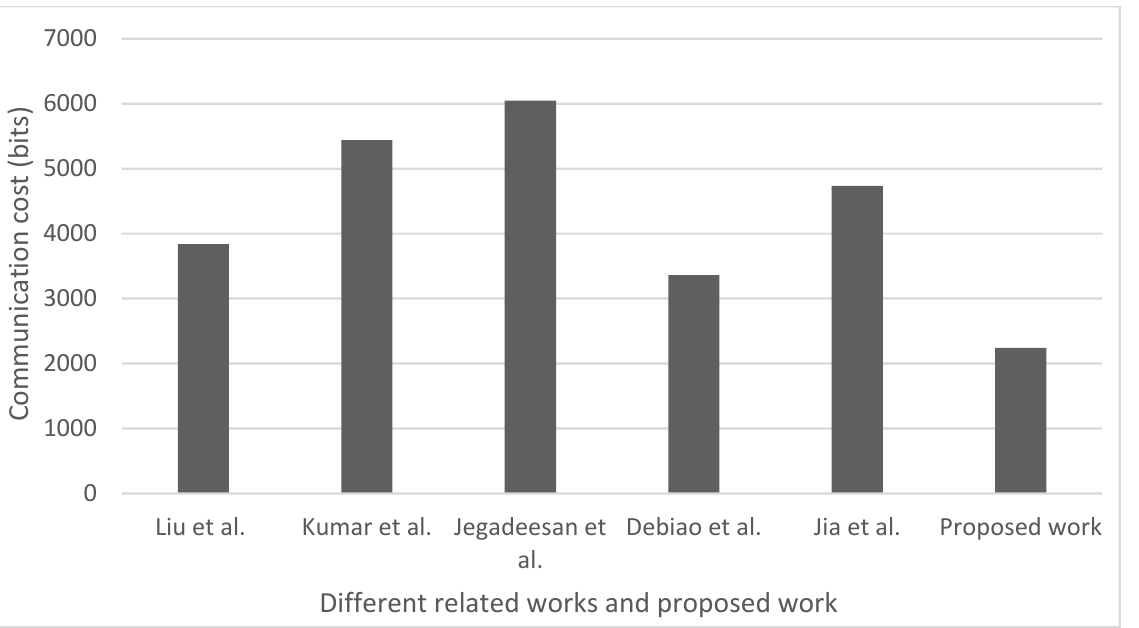
Figure 4. Communication overhead for analyzed authentication schemes (Liu at al. [49], Kumar at al. [44], Jegadeesan et al. [50], Debiao et al. [51] and Jia at al. [52]).